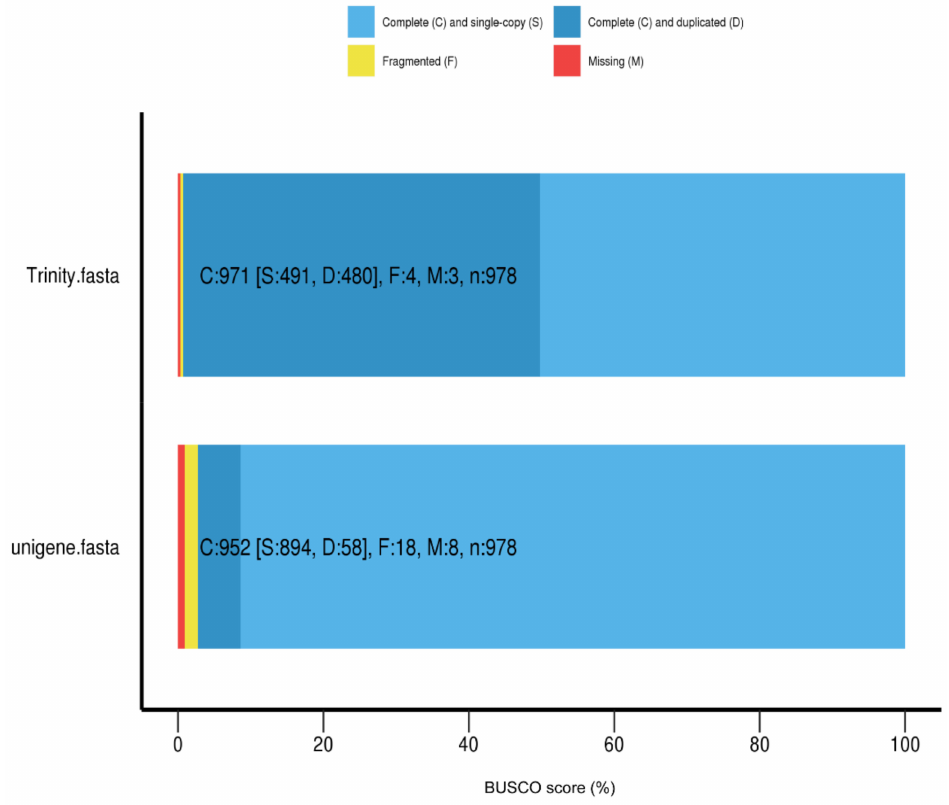
Figure 1. Transcriptome completeness of de novo assembled Vespa velutina transcripts and unigenes using Benchmarking Universal Single-Copy Orthologs